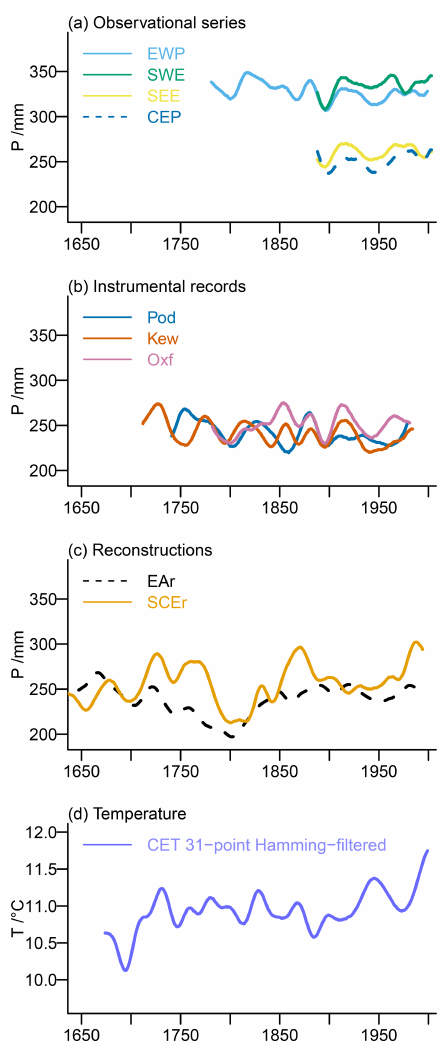
Figure 1. Visualization of the observation-based records for the ex- tended spring season March to July (MAMJJ). We show 31-point Hamming-filtered time series for (a) the Met Office Hadley Centre observational precipitation series for England–Wales (EWP), south- west (SWE), southeast (SEE), and central England (CEP), (b) the instrumental precipitation series for Pode Hole (Pod), Kew Gar- dens (Kew), and Oxford (Oxf), (c) the precipitation reconstruc- tions for East Anglia (EAr) and southern–central England (SCEr), and (d) the Central England Temperature (CET)